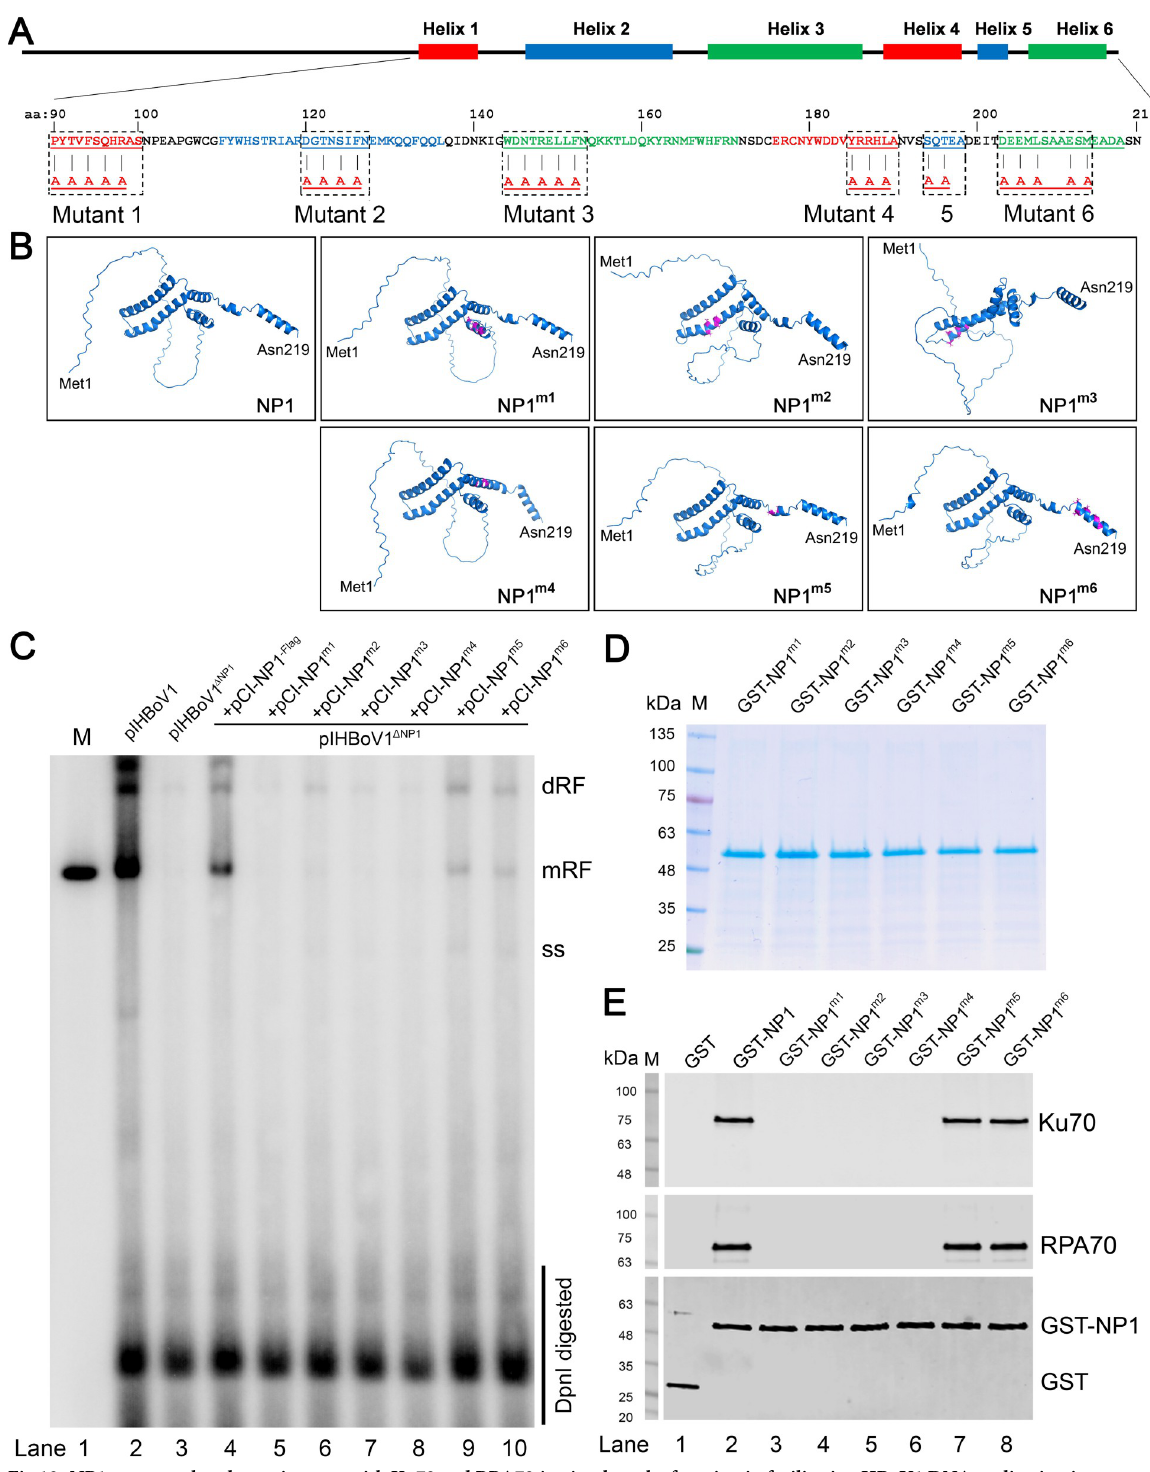
Fig 13. NP1 mutants that do not interact with Ku70 and RPA70 in vitro lose the function in facilitating HBoV1 DNA replication in HEK293 cells. (A) Schematic digram of the NP1 protein. NP1 protein is schematically diagramed with predicated helical strutrues. The amino acid sequences of aa90-219 are shown with indication of each helix. The potential functional motifs (underlined) within each helical struture were predicted with Eukaryotic Linear Motif resource. NP1 mutants that bear mutaions in helix structure 1–6 are indicated. (B) Prediction of NP1 structures . The structures of NP1 and its mutants were predicated with AlphaFolder2. (C) Southern blotting. HEK293 cells